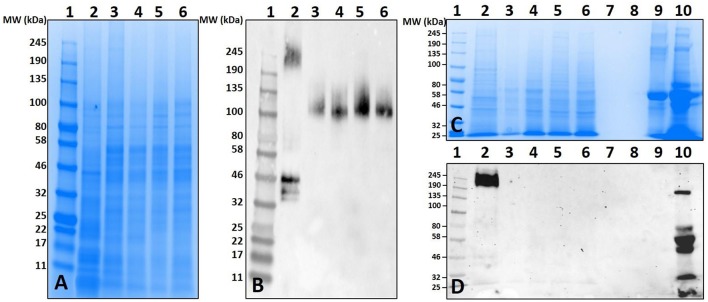
Identification of α-gal in the salivary gland and gut tissues of Ixodes scapularis during the blood meal. (A) SDS-PAGE of Ix. scapularis salivary glands using 7.5% Mini-PROTEAN TGX, (B) western blot using anti-gal IgM antibody. Lane 1, A broad range (11–245 kDa) prestained protein standard; Lane 2, Ix. scapularis unfed SG; Lane 3, Ix. scapularis 3D partially-fed SG; Lane 4, Ix. scapularis 5D partially-fed SG; Lane 5, Ix. scapularis 6D partially-fed SG; Lane 6, Ix. scapularis 8D partially-fed SG. (C) SDS-PAGE of Ix. scapularis midgut tissues. Lane 1, A broad range (11–245 kDa) prestained standard; Lane 2, Ix. scapularis unfed gut tissues; Lane 3, Ix. scapularis 3D partially-fed gut tissues; Lane 4, Ix. scapularis 5D partially-fed gut tissues; Lane 5, Ix. scapularis 6D partially-fed gut tissues; Lane 6, Ix. scapularis 8D partially-fed gut tissues; Lane 7–8, blank. Lane 9, Bovine serum albumin; and, Lane 10, Diluted sheep blood. (D) Western blot using anti-gal IgM antibody.